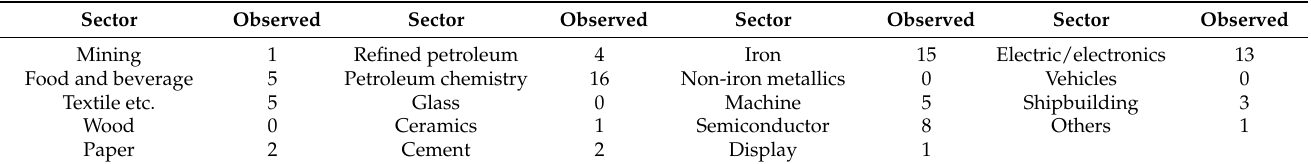
Table 4. Observations of five main industries influencing GHG emission